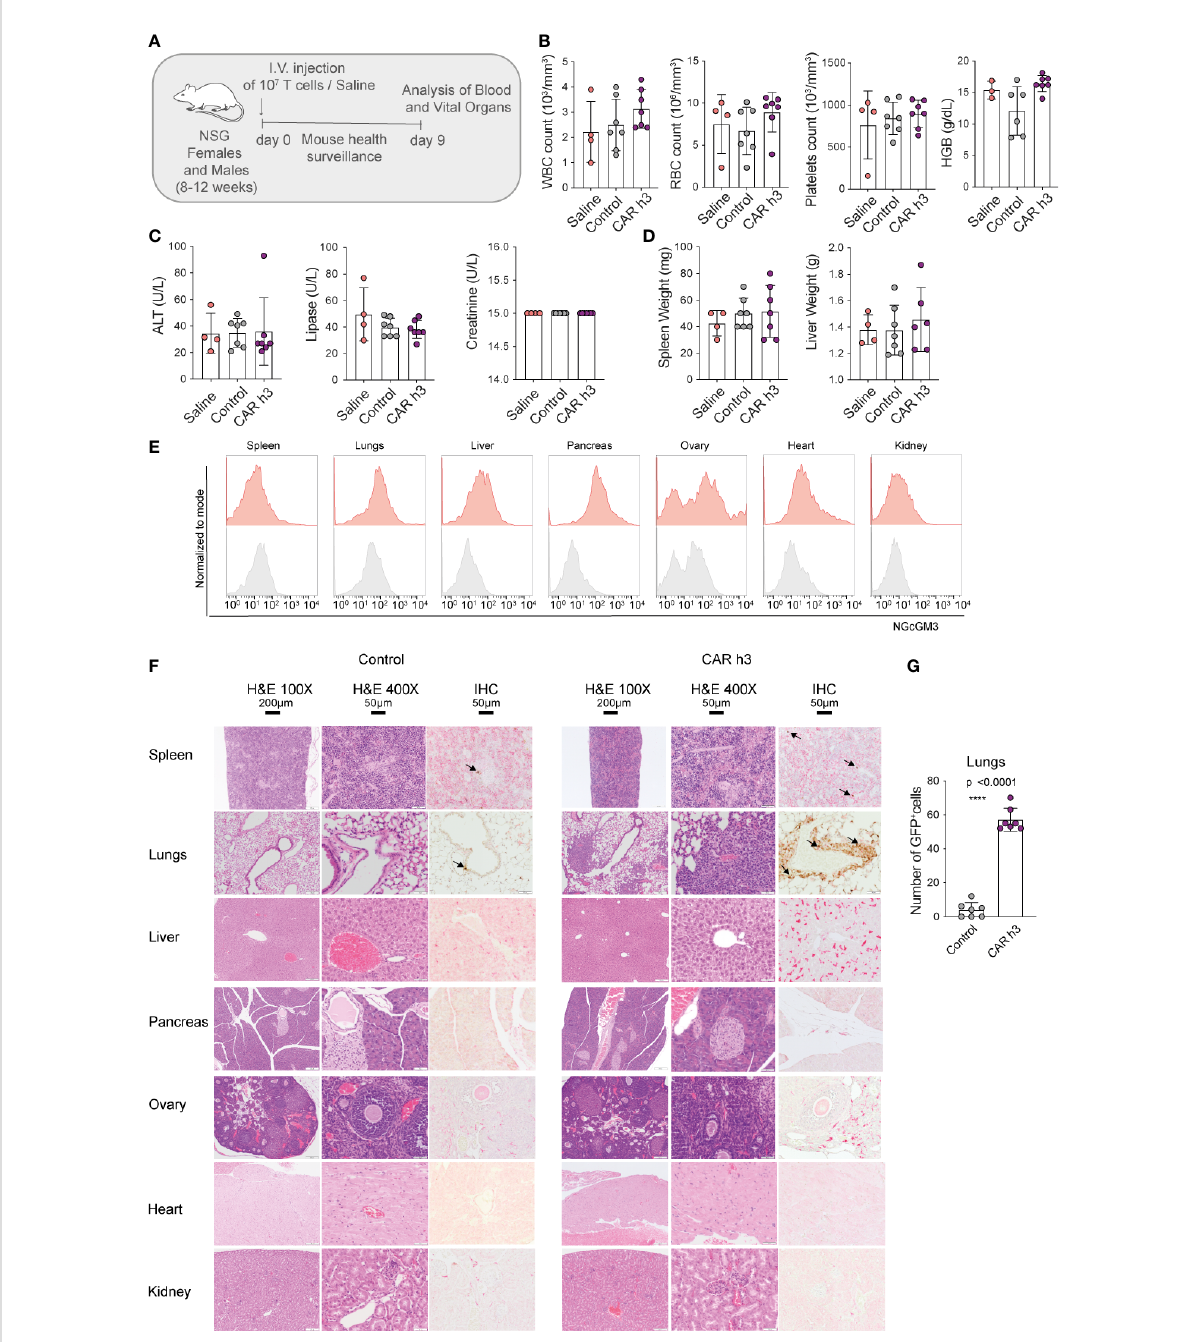
FIGURE 3 Anti-NGcGM3 CAR T cells do not cause toxicity in NSG mice. (A) Schematic of in vivo toxicity study. (B) Blood analysis to assess white blood cells (WBC), red blood cells (RBC), platelets counts and hemoglobin (HGB). (C) Measurement of alanine aminotransferase (ALT), lipase and creatinine in serum. (D) Spleen and liver weight upon necropsy. (E) NGcGM3 expression in different organs (spleen, lungs, liver, pancreas, ovary, heart, kidney). (F) Histopathology of organs from control (GFP transduced T cells) and anti-NGcGM3 CAR h3 T cell treated mice on day 9 post intravenous injection of transduced 10 7 T cells. H&E = hematoxylin and eosin staining at 100X and 400X magni fi cation; IHC = immunohistochemistry to detect GFP + T cells (brown, indicated with arrow). (G) Quanti fi cation of GFP + T cells in the lungs. Shown is average ± SD (B, C, D, G) . Statistical analysis by unpaired, two-tailed t test (G) . (****p<